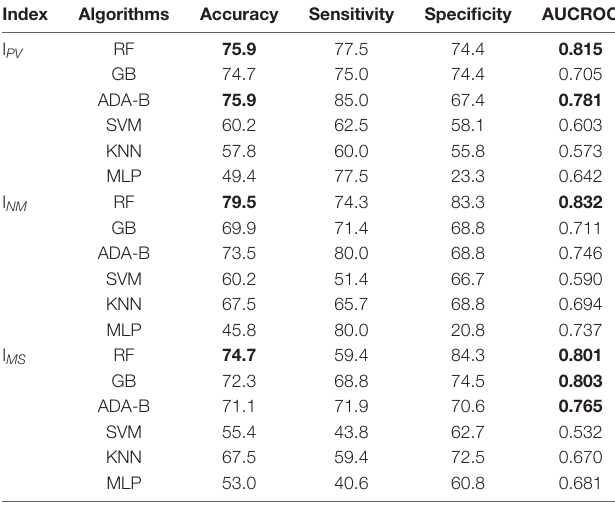
TABLE 6 | Evaluation metrics after the classification ML analysis for I PV , I NM , and I MS